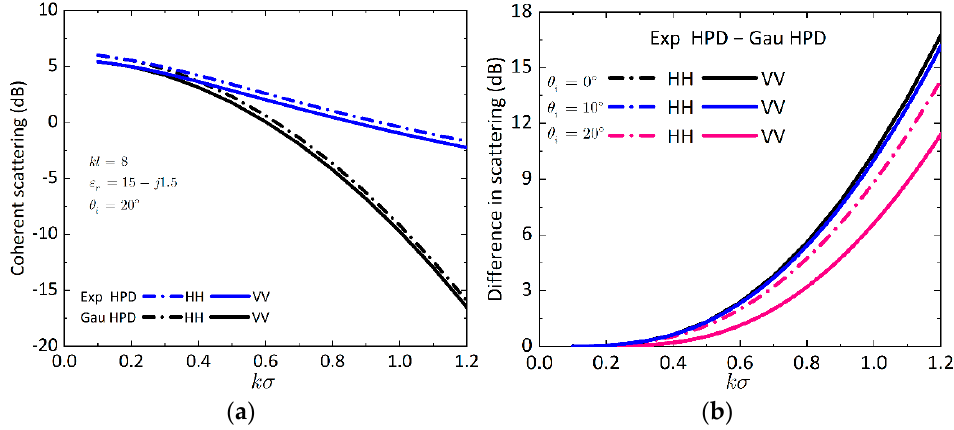
Figure 3. ( a ) Comparison of the coherent scattering between Gaussian and exponential HPD rough surface; ( b ) Difference between exponential and Gaussian HPD rough surface. surface; ( b ) Difference between exponential and Gaussian HPD rough